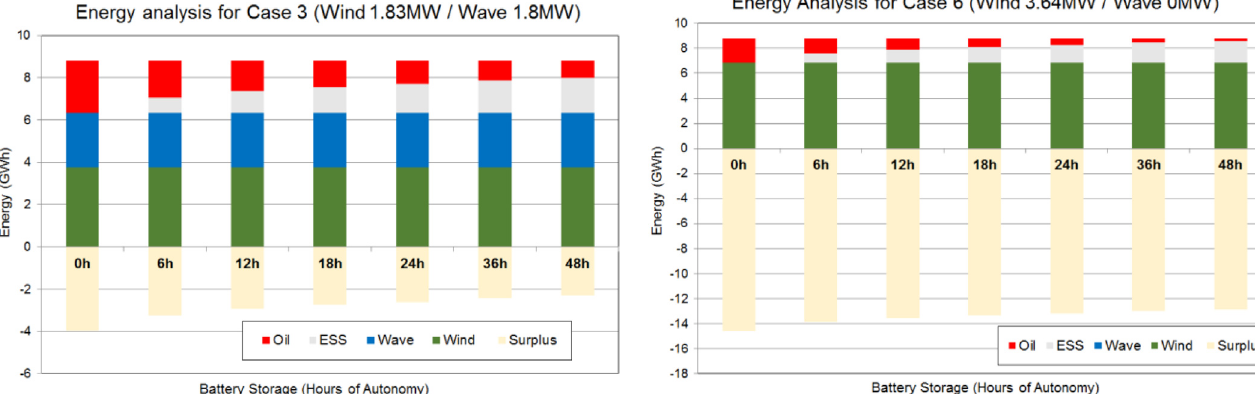
Fig. 15. Proposed solution energy analysis for case